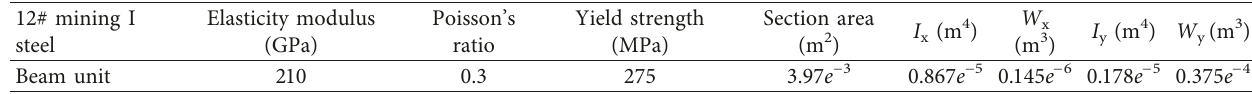
Table 2: Mechanical parameters of 12# mining I steel.